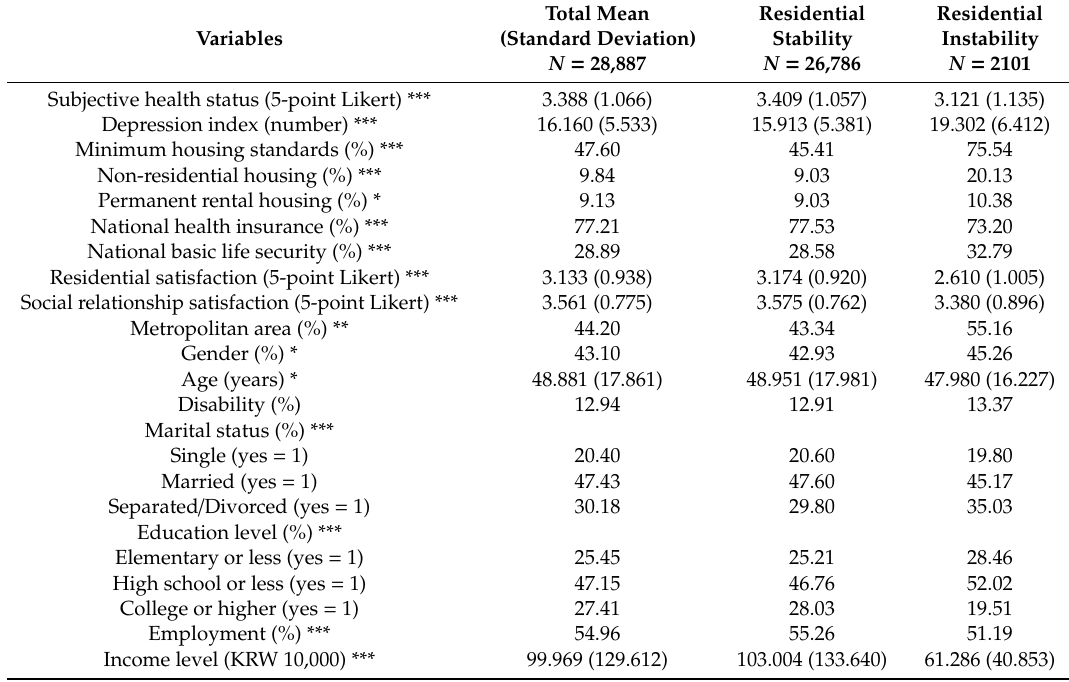
Table 3. Descriptive statistics for renters with and without residential